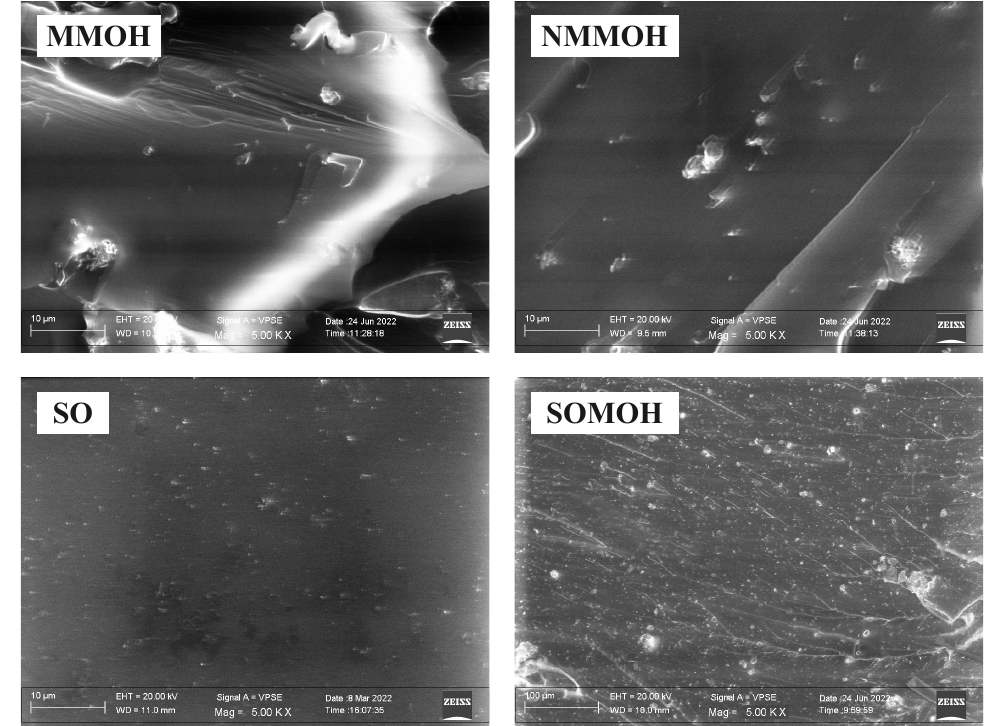
Figure 4. FESEM (5000 × ) of PU hybrid composites with different fillers including nMOH, mMOH, and SO. While the hybrid and nanocomposite sample (SOMOH) demonstrated a uniform microstruc- ture with homogeneous roughness, the hybrid and microcomposites presented more roughness and heterogeneity in